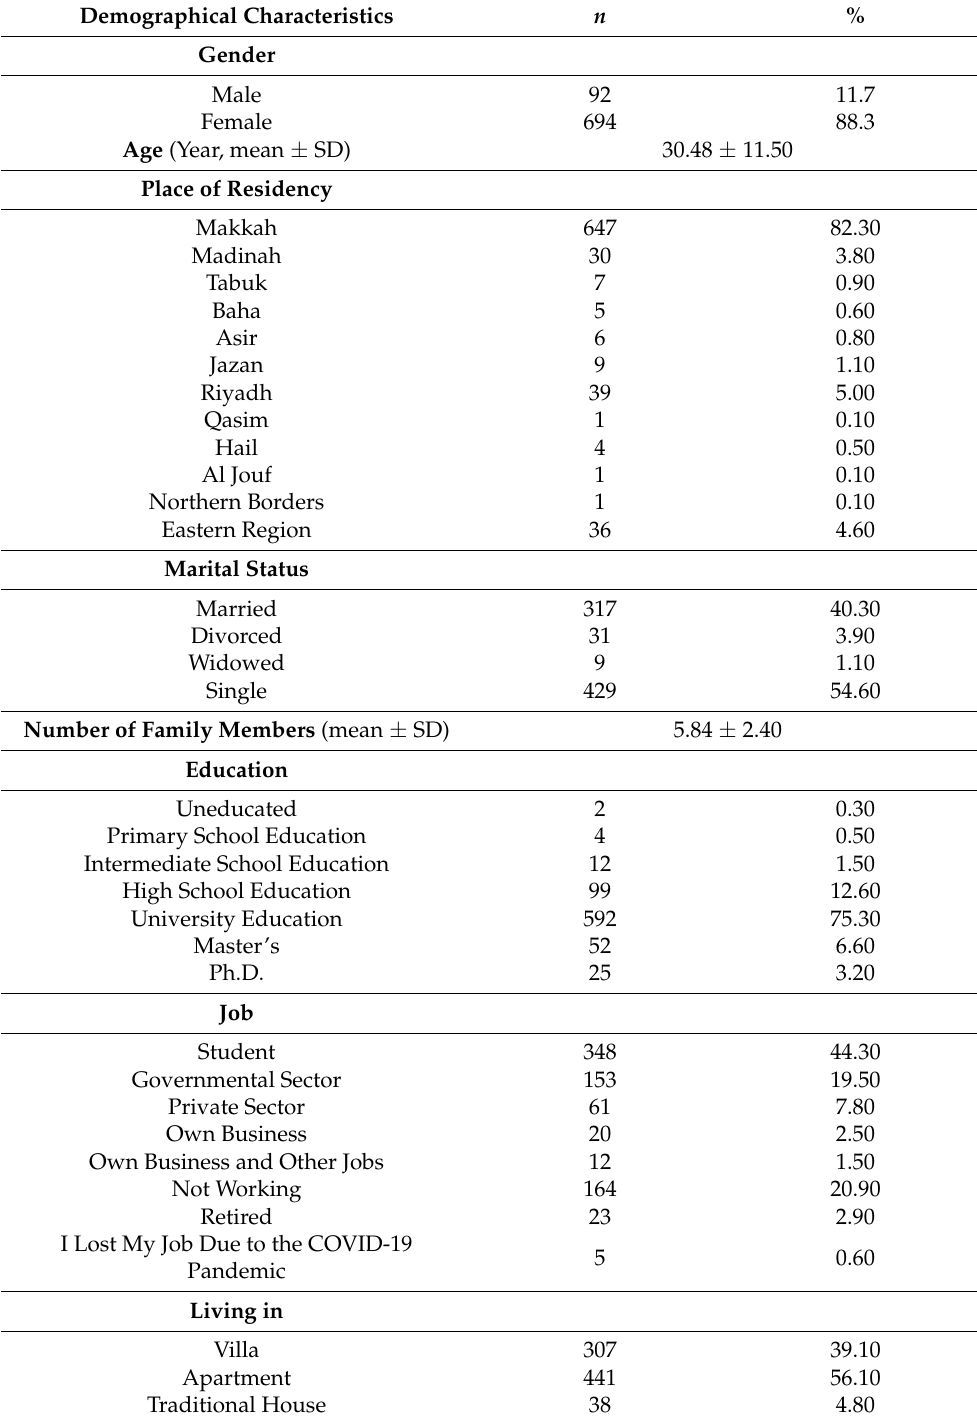
Table 1. Socio-demographic profile of the Saudi participants ( n =